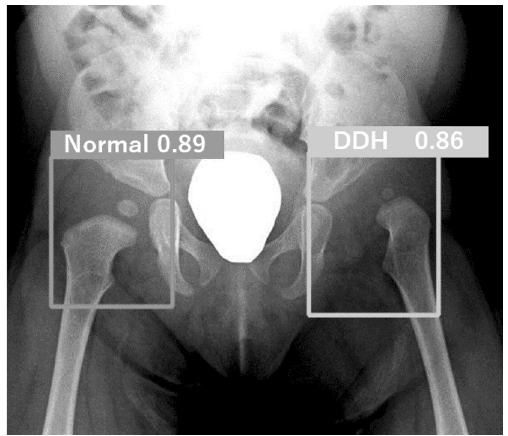
Figure 2. Example of a test image outcome. The right hip was labeled “Normal” and the left hip was labeled “DDH”, with class-specific confidence scores. Both hips were correctly labeled. DDH Developmental dysplasia of the